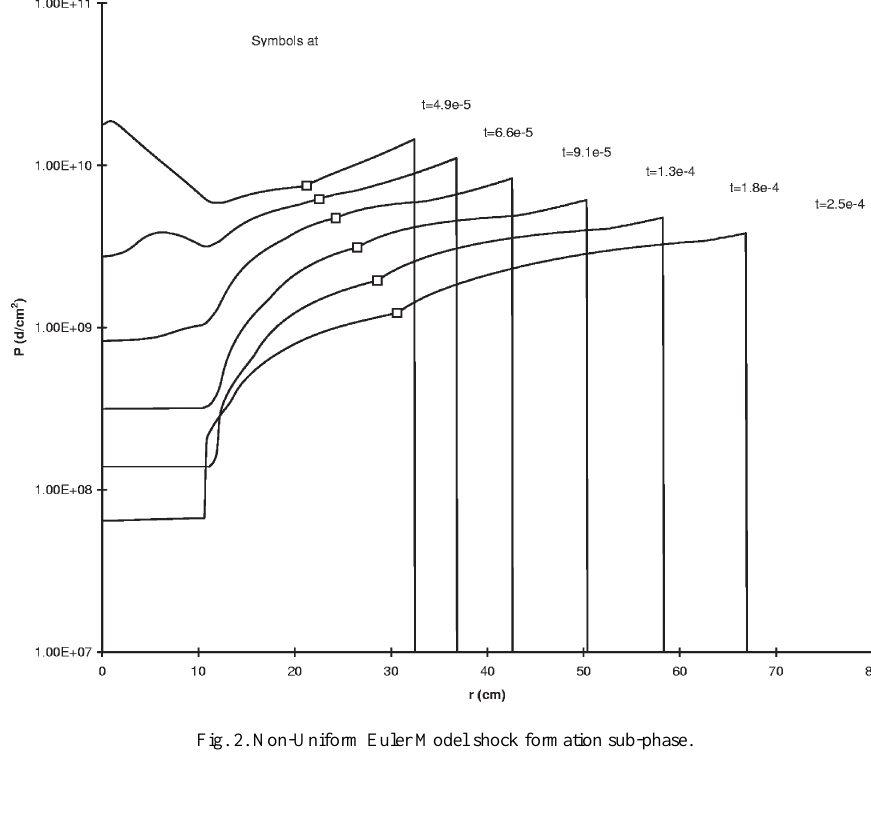
Fig. 2. Non-Uniform Euler Model shock formation sub-phase.